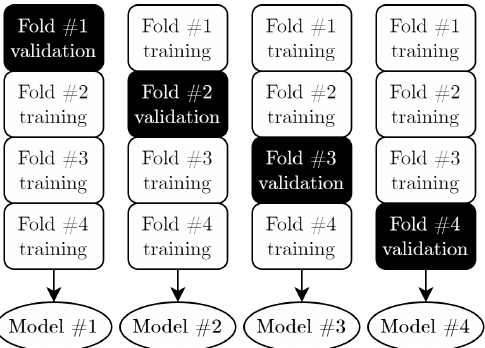
Figure 9. Operating principle of the K-Folds cross validator. The shuffling of the stratified sets leads to dissimilar models per